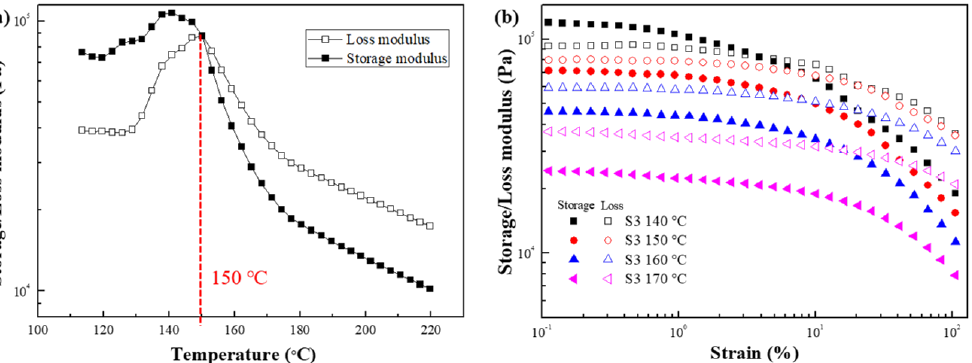
Figure 12. Storage (closed symbols) and loss (open symbols) modulus of ( a ) temperature sweep test and ( b ) strain amplitude sweep test for S3.